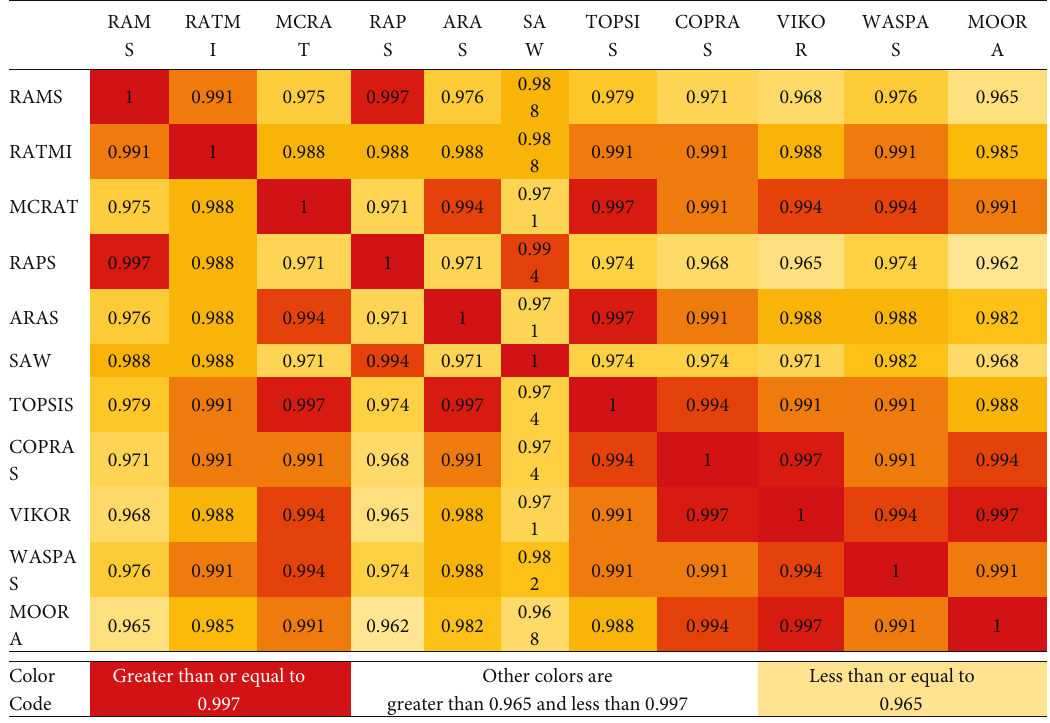
Figure 3: The density of the correlation between the compared techniques is displayed on a heatmap. Greater signi fi cance of the correlation factor is shown by denser colour than by lighter colour. That is shown by the table ’ s colour